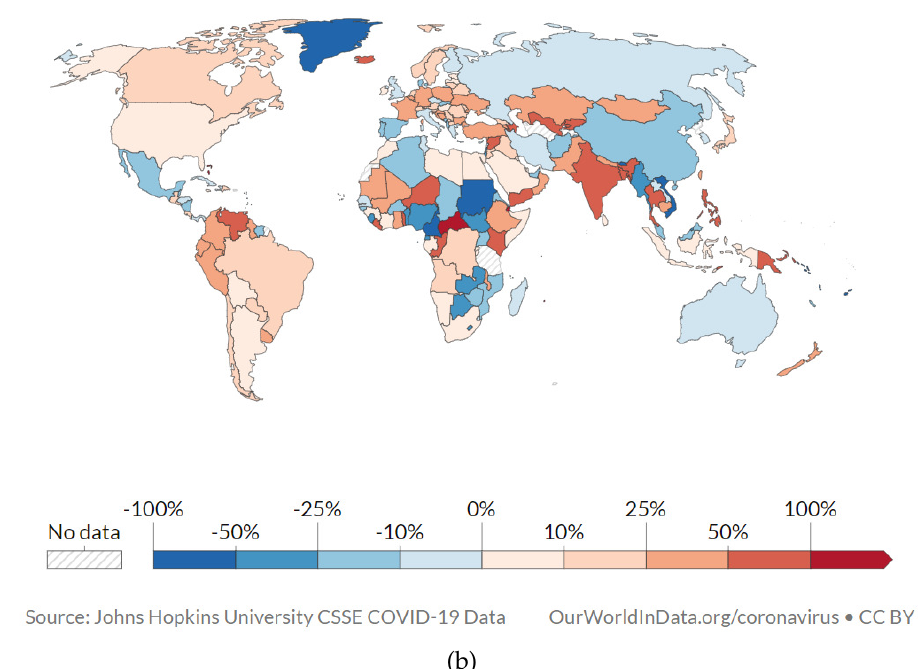
Figure 3. Week by week change in confirmed COVID-19 cases: ( a ) March 2020, ( b ) March 2021.